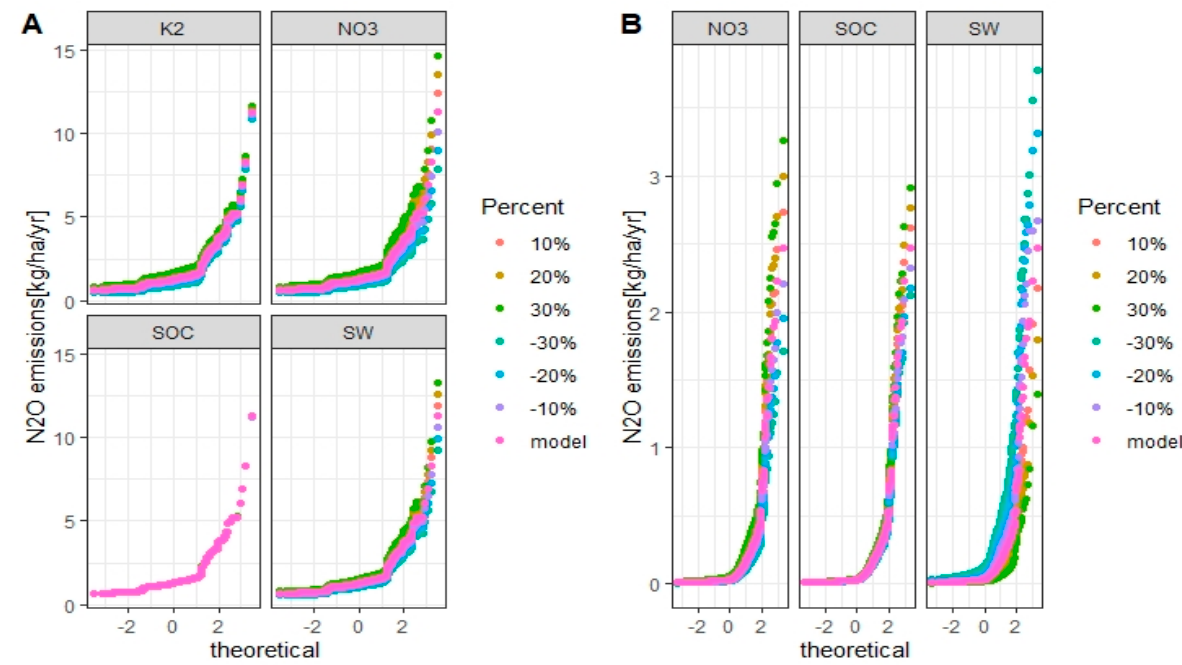
Figure 12. Uncertainties of simulated annual N 2 O emissions from winter wheat in the Melk catchment with M1 ( A ) and M2 ( B ) setups for each considered factor. The X-axis is the standard normal distribution of simulated N 2 O emissions with mean 0 and standard deviation 1. Model is the validated SWAT model and is the baseline.